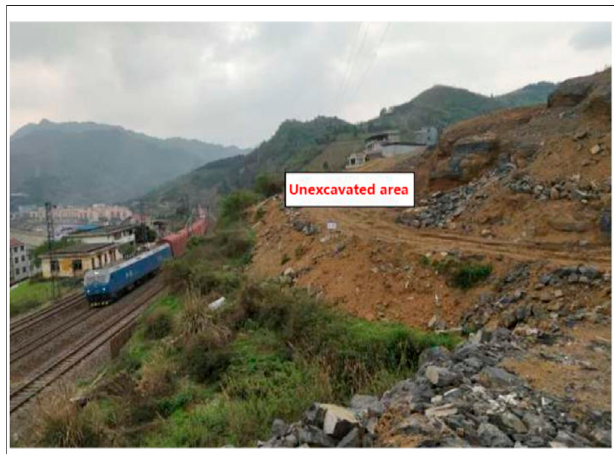
FIGURE 4 | Blasting excavation